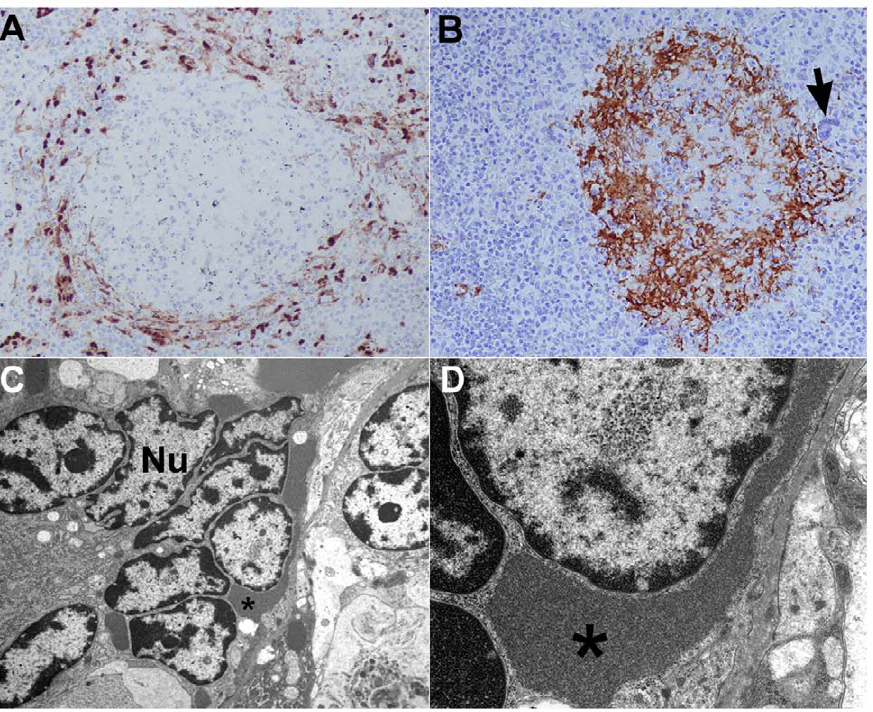
Figure 2. NiV infection and pathogenesis in the spleen. Panels A–D; Subject 1 that succumbed on day 9 after i.t. and oral challenge with 1.3 6 10 6 pfu of NiV. (A) Localization of NiV by immunohistochemistry; 20 6 magnification. Scattered foci of immunopositive cells (brown) abundant in the parafollicular area. Note severe lymphocytolysis of follicle. (B) Localization of fibrin by immunohistochemistry showing abundance of fibrin (brown) in and around follicle from different section than panel A; 20 6 magnification. A multinucleate giant cell is evident in parafollicular area (arrow). (C) Transmission electron micrograph of spleen multinucleate giant cell 4,000 6 magnification, Nu, nucleus and asterisk indicates prominent intracytoplasmic paramyxoviral inclusions; and D: 20,000 6 magnification of asterisk indicated area shown in panel